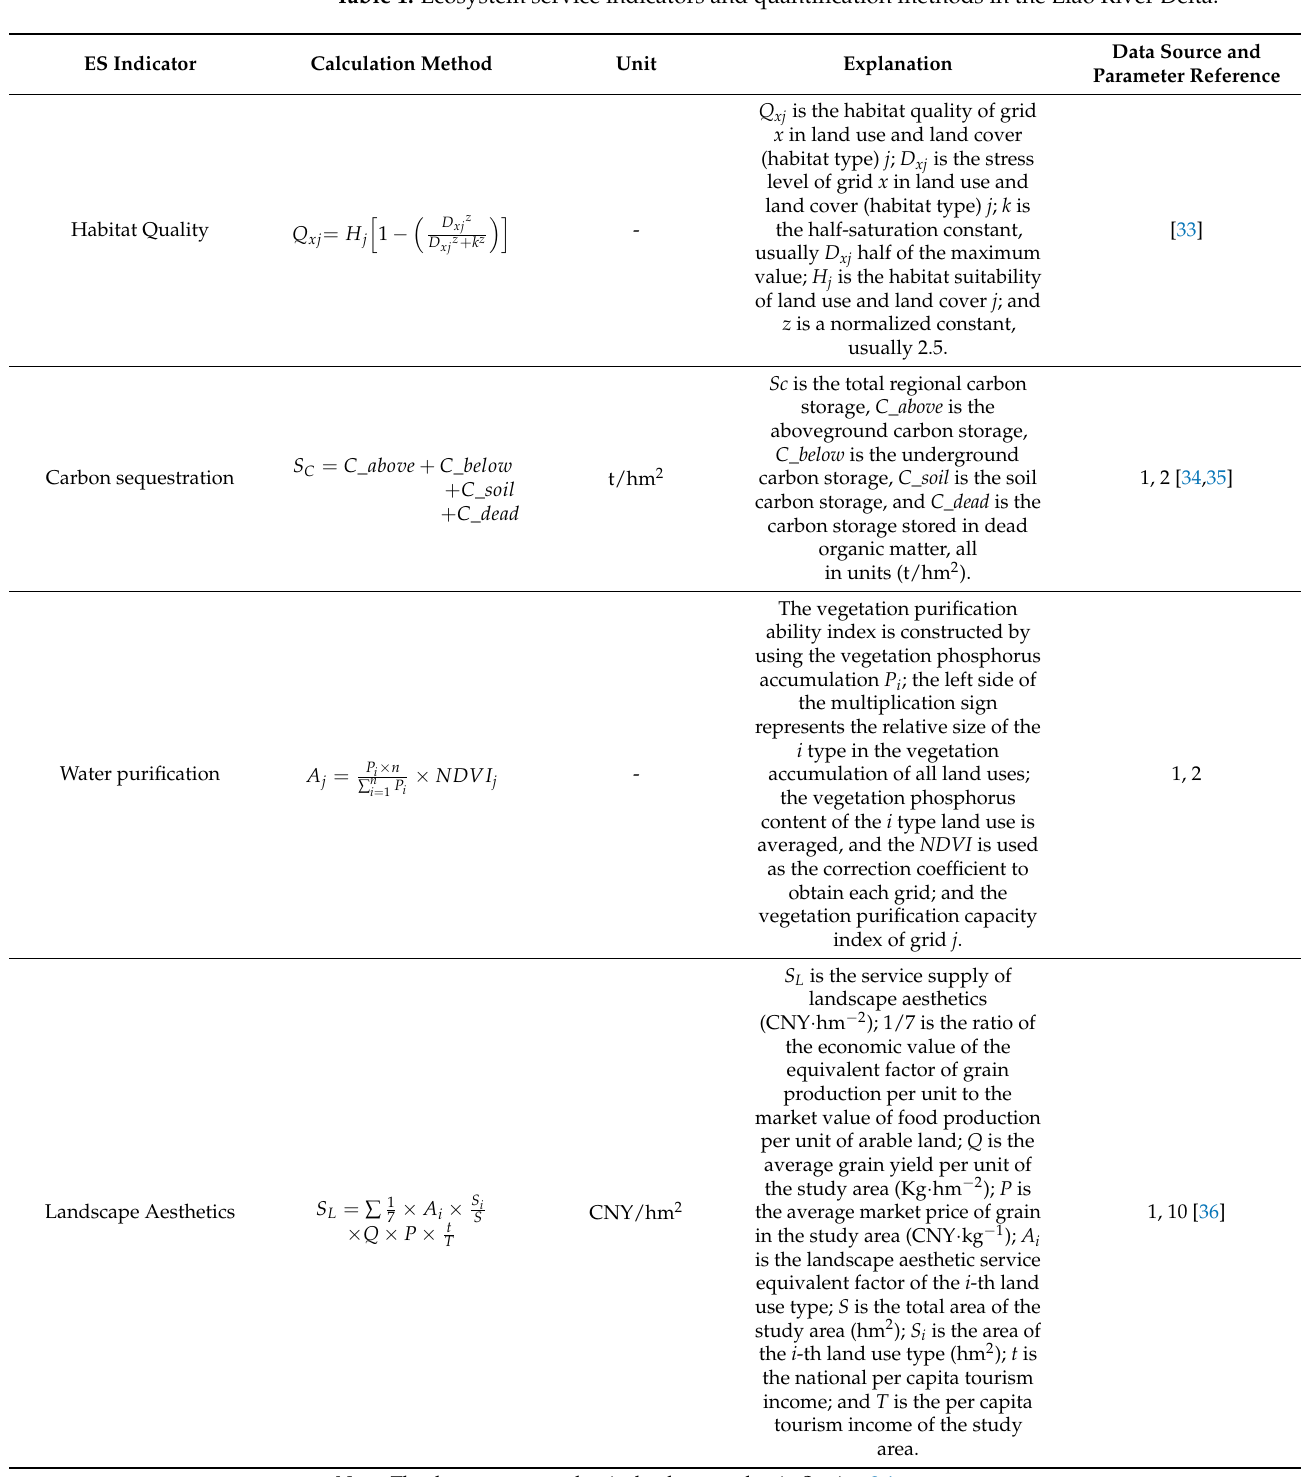
Table 1. Ecosystem service indicators and quantification methods in the Liao River